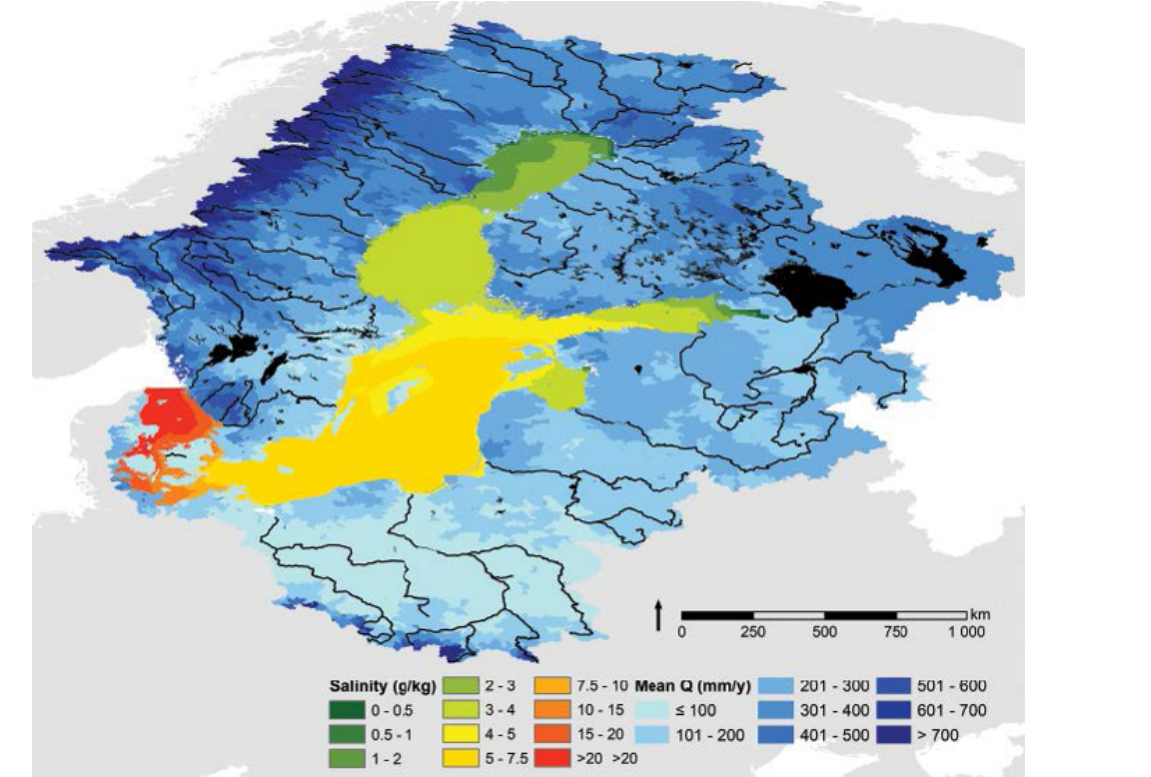
Figure 1. The Baltic Sea drainage basin, showing the spatial variability in annual mean water discharge ( Q ) calculated with the HYdrological Predictions for the Environment (HYPE) model and the annual mean sea surface salinity in the Baltic Sea. This salinity diagram shows the gradient from high (red) to low (green) salinities, calculated with the Rossby Centre Ocean model. The figure is sourced from Meier et al.